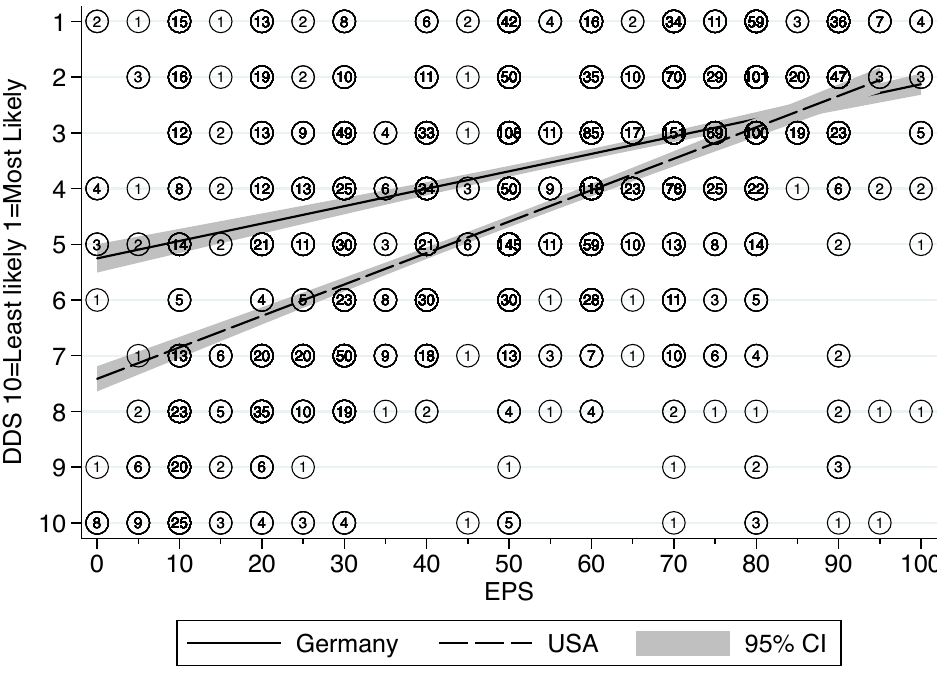
Figure 3. Linear regression of the relationship between differential diagnosis scale and estimated probability scale. Comparison of pediatricians from the US and